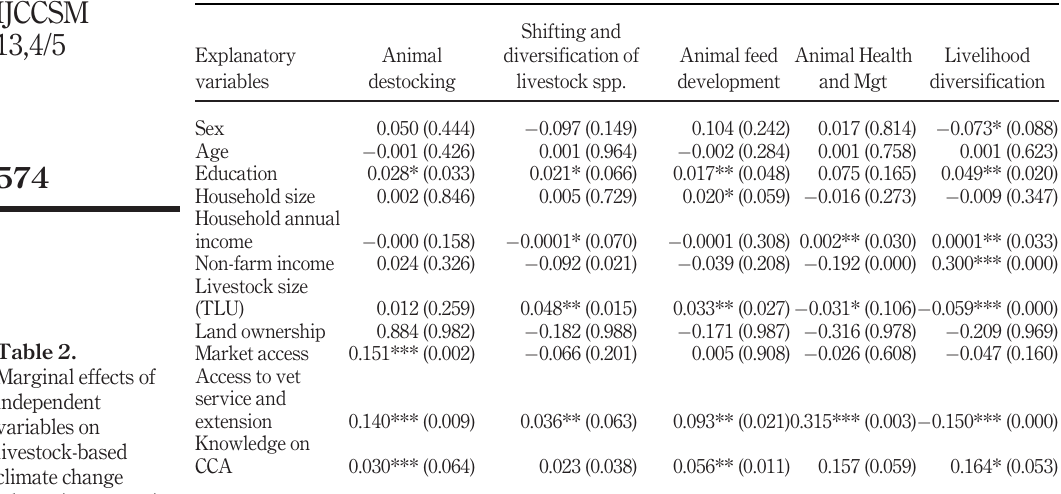
Table 2. Marginal effects